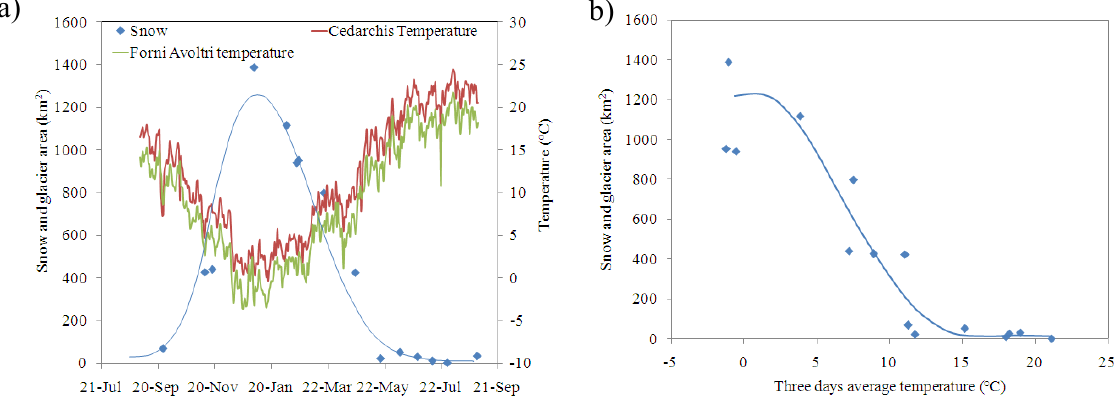
Fig. 3. Glacier and snow cover area during two time periods; (a) from band combination method and (b) from NDSI index. Fig. 3 Glacier and snow cover area during two time periods; a) from NDSI index and b) from band combination method.